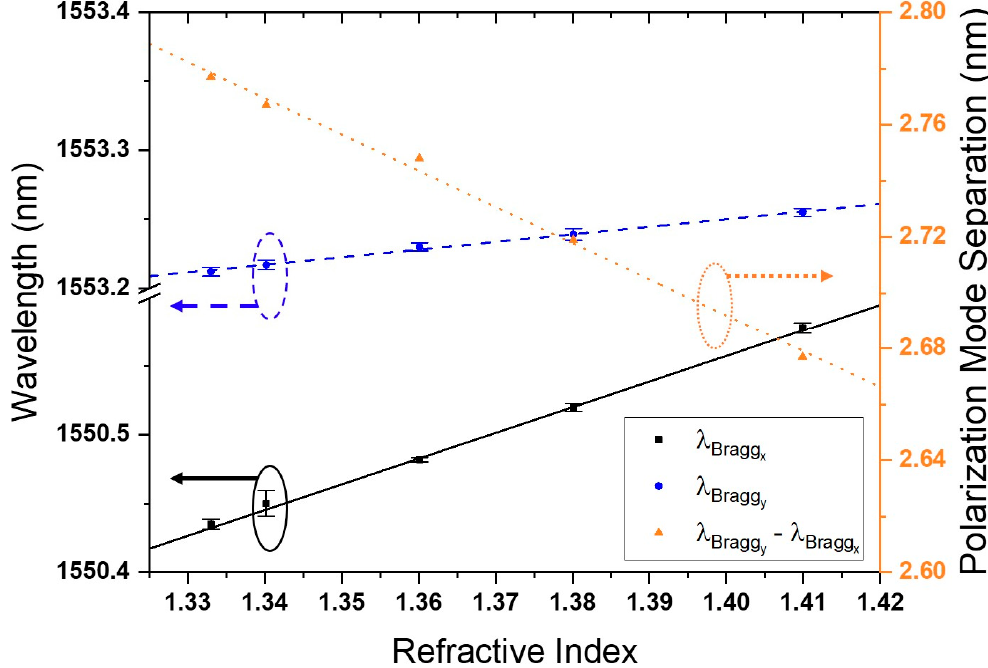
Figure 9. Sensor response to changes in ambient refractive index.